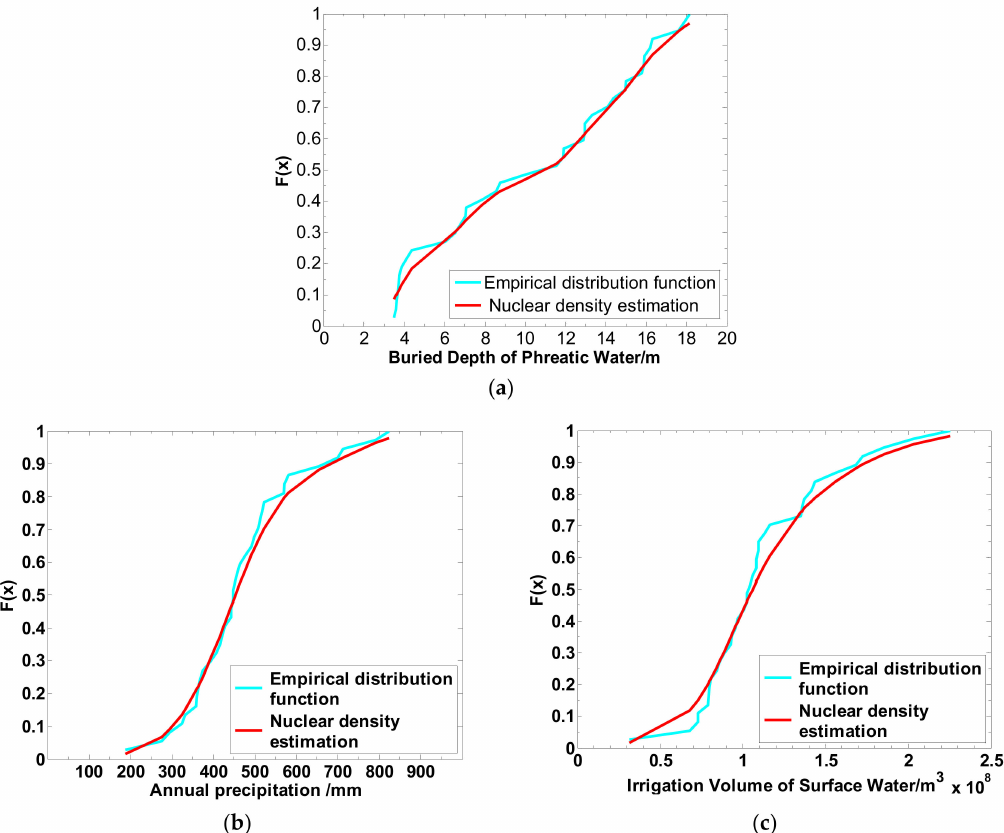
Figure 3. Estimation image of the Kernel Distribution of the groundwater buried depth, annual precipitation, and irrigation volume of the surface water. ( a ) Marginal distribution of the phreatic water buried depth; ( b ) marginal distribution of the annual precipitation; and, ( c ) marginal distribution of the irrigation volume of the surface